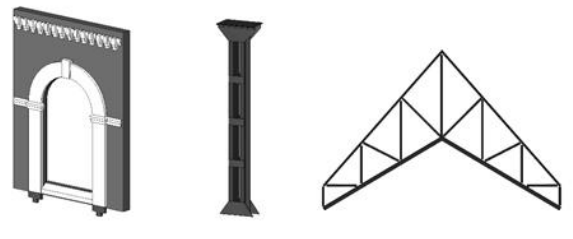
Figure 4. Left to right: window opening, stanchion, roof truss